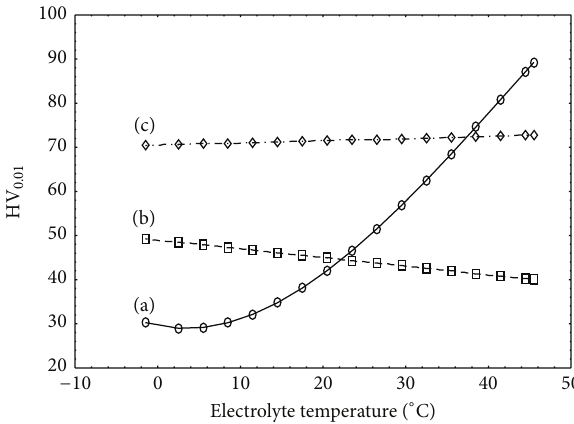
Figure 4: The dependence of the layer microhardness on the tem- perature of the electrolyte: c (H 2 SO 4 ) = 0.09 mol ⋅ L −1 , c (C 2 H 2 O 4 ) = 0.06 mol ⋅ L −1 , U = 10V, t = 15min. (a) 1A ⋅ dm −2 , (b) 3A ⋅ dm −2 , and (c) 5 A ⋅ dm −2 .